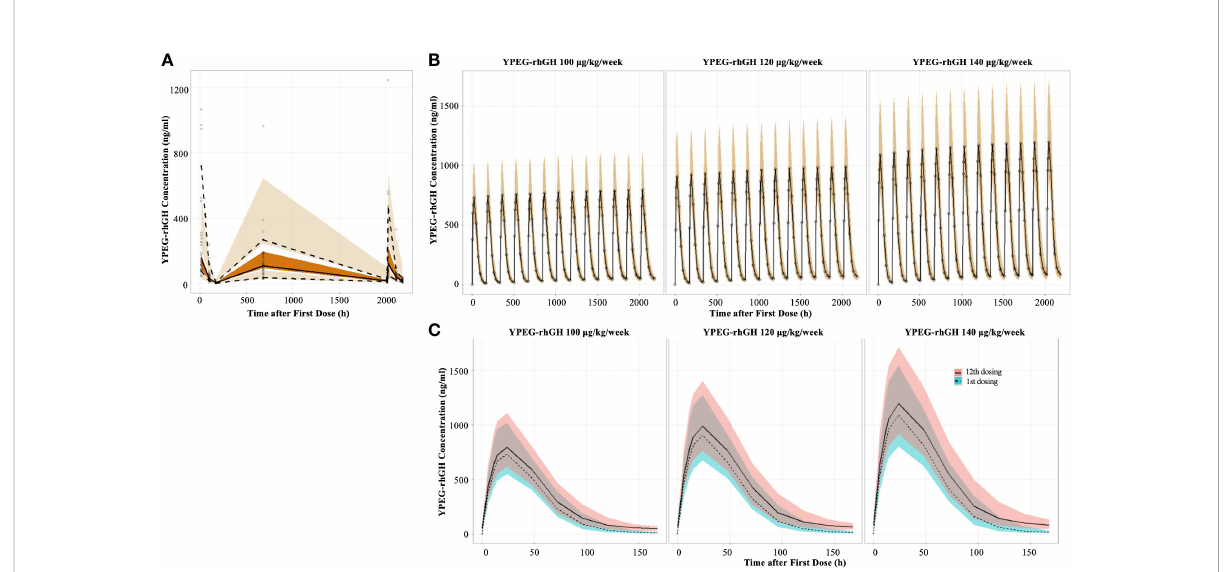
FIGURE 1 Model-derived PK pro fi les of YPEG-rhGH (A) , Prediction-corrected visual predictive checks (pcVPC) of the YPEG-rhGH concentration. The hollow dots indicated the prediction-corrected YPEG-rhGH concentration. The top dashed line, the middle solid line and the bottom dashed line indicated 10th percentile, median and 90th percentile of prediction-corrected YPEG-rhGH concentrations. The top, middle and bottom area indicated the 95% con fi dence interval of each line. (B) , model-derived PK pro fi les of YPEG-rhGH in the 12-week treatment period. The hollow dots and solid line indicated the median of YPEG-rhGH concentrations. The shallow area indicated the 5% and 95% con fi dence intervals predicted by the model. (C) , model-derived PK pro fi les of YPEG-rhGH within one treatment interval after the fi rst and last dosing. The green and pink area indicated the 95% con fi dent interval of YPEG-rhGH concentration after the fi rst and last